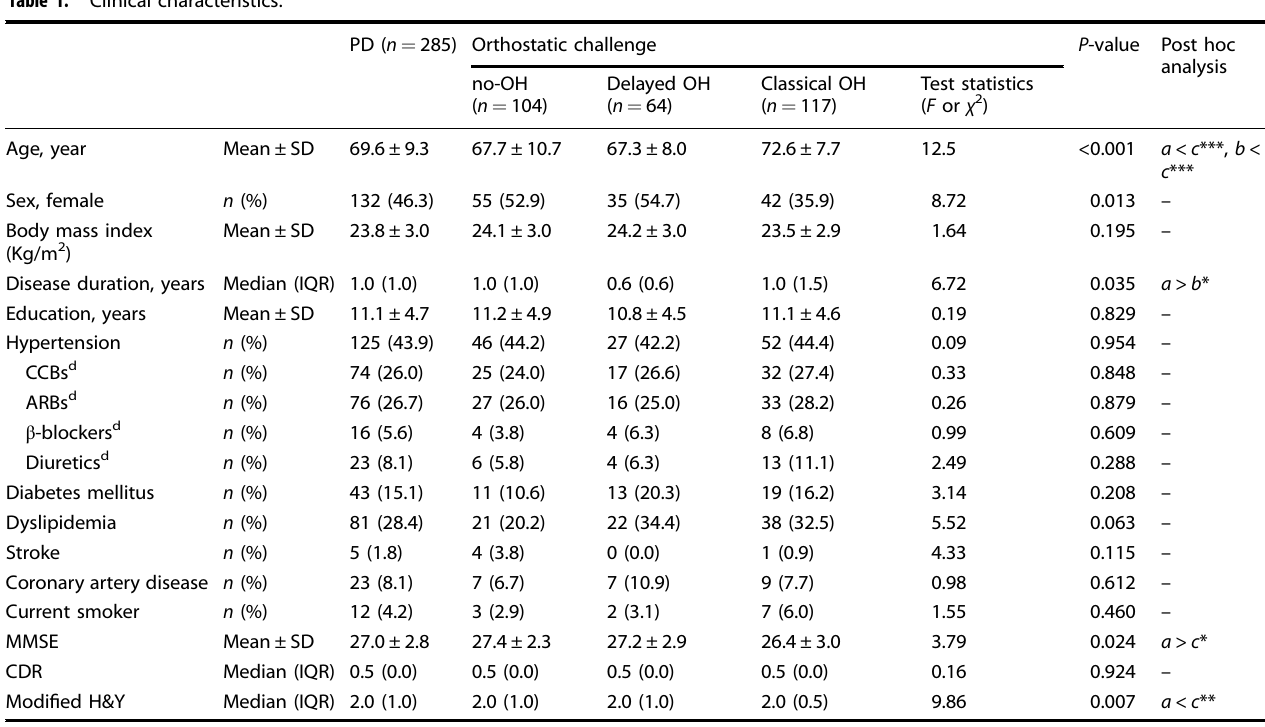
Analysis of variance was used for continuous variables and the χ 2 test for categorical variables. Non-normally distributed variables were analyzed by the Kruskal – Wallis test. Pairwise multiple comparisons were adjusted by Tukey ’ s HSD, Games-Howell or Dwass-Steel-Critchlow-Fligner tests, when appropriate. PD Parkinson ’ s disease, OH orthostatic hypotension, CCB calcium channel blocker, ARB angiotensin II receptor blocker, MMSE Mini-Mental Status Examination, CDR Clinical Dementia Rating, H&Y Hoehn and Yahr, SD standard deviation, IQR interquartile range. * p -value<0.05, ** p -value< 0.01, *** p -value<0.001 a no-OH, b Delayed OH, c Classical OH, d Some patients were prescribed in